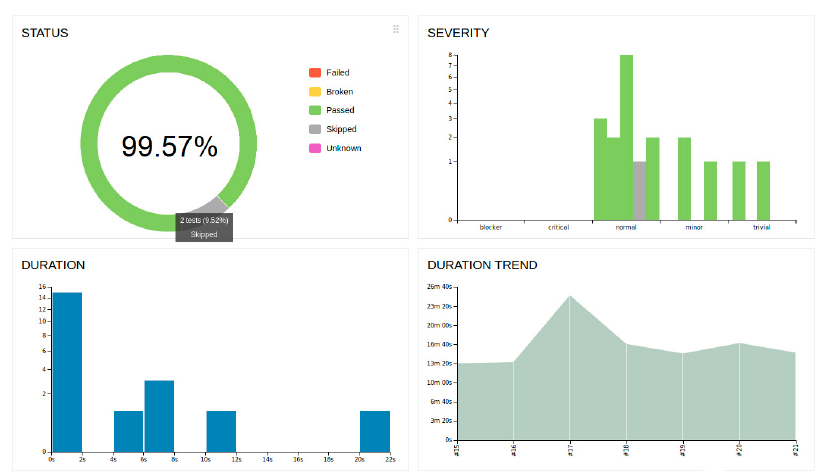
Sensors 2019 , 19 , 4455 Figure 8. Test TLS client via the Pytest module. Figure 8. Test TLS client via the Pytest module.